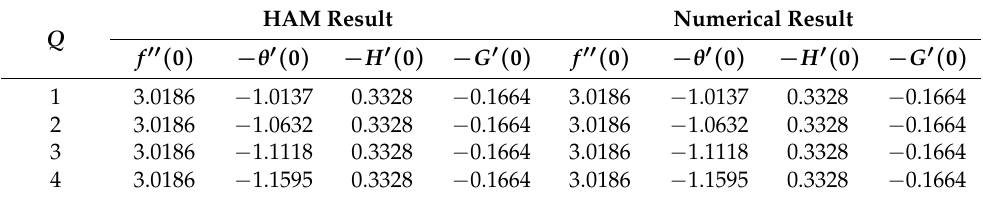
Table 8. Computational for f (cid:48)(cid:48) ( 0 ) , − θ (cid:48) ( 0 ) , − H (cid:48) ( 0 ) and − G (cid:48) ( 0 ) with S = − 0.5, P r = Ha = R = Sc = K 1 = K 2 = 0.5, L = δ = 2 and differing values of Q .